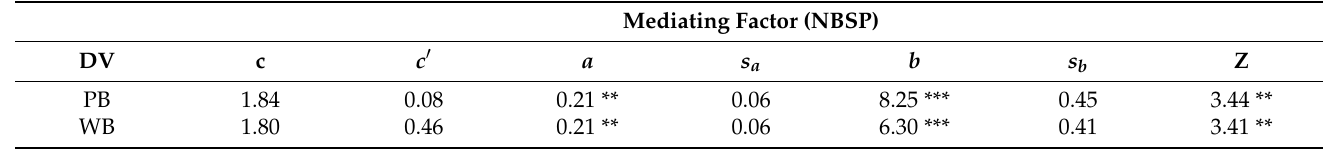
Table 5. Mediation effect of NBSP between sex and